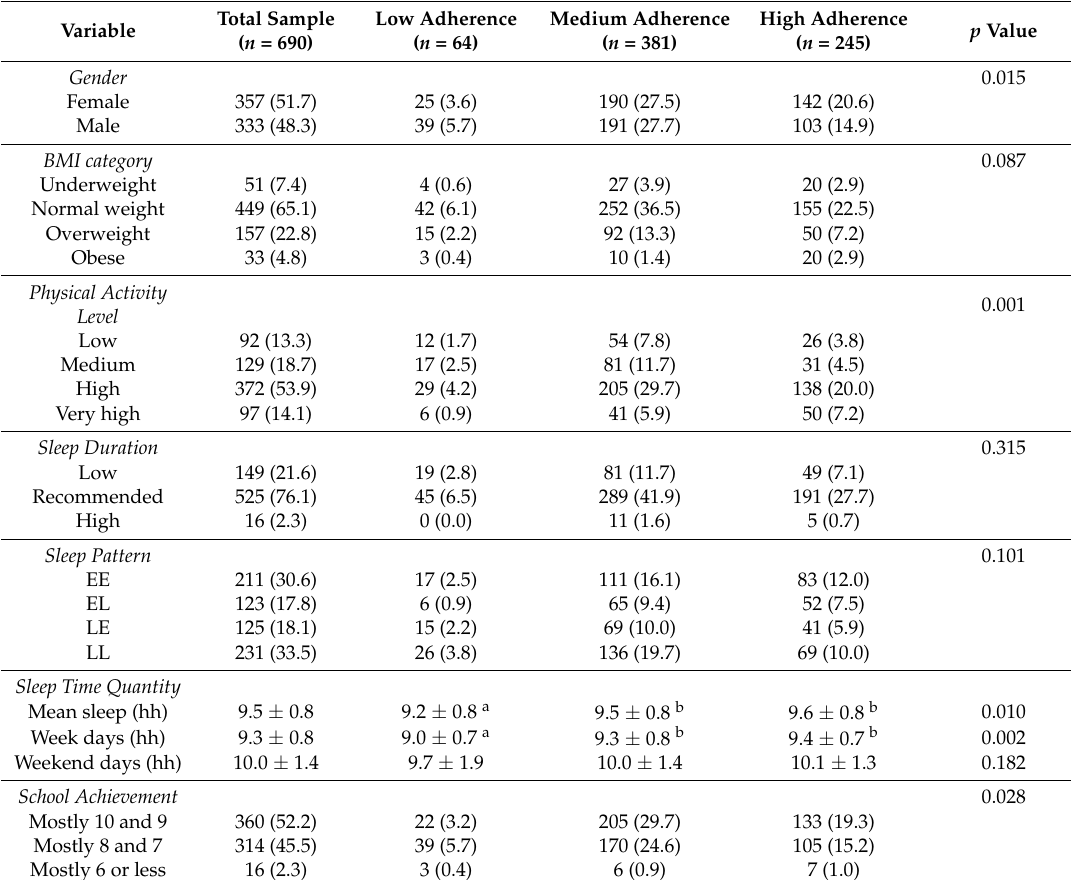
Table 3. Dietary habits, lifestyle, school achievement, and sleeping behaviors by adherence to the Mediterranean diet (MD).